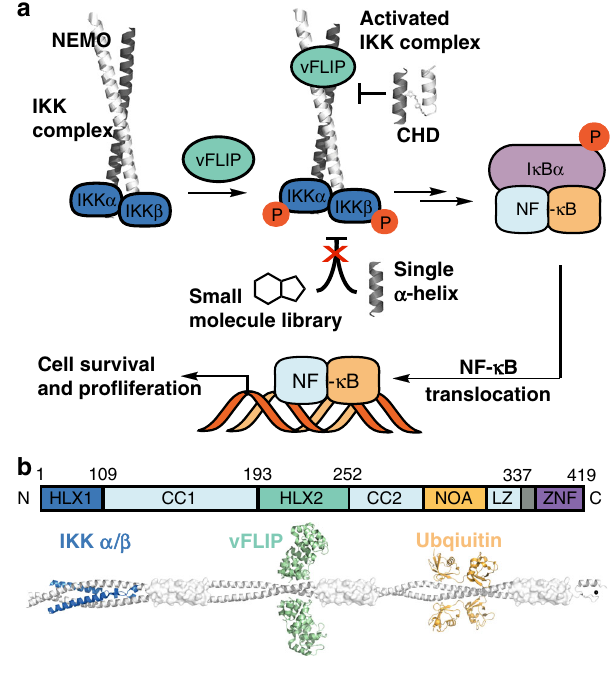
Fig. 1 Overview of vFLIP-mediated activation of NF- κ B signaling pathway. a Binding of vFLIP, a viral oncoprotein, to NEMO activates NF- κ B signaling. NEMO adopts a helical coiled coil motif to bind to vFLIP (PDB Code 3CL3). We explored small molecule libraries, stabilized α -helices, and crosslinked helix dimers (CHDs) to inhibit NEMO – vFLIP complex formation. Potent inhibition required a CHD motif that captured critical contacts from both helices of NEMO coiled coil. b Cartoon depicts various binding partners of NEMO responsible for activating and repressing NF- κ B. vFLIP shown here in green binds the second helical domain (HLX2) downstream of the IKK α / β binding